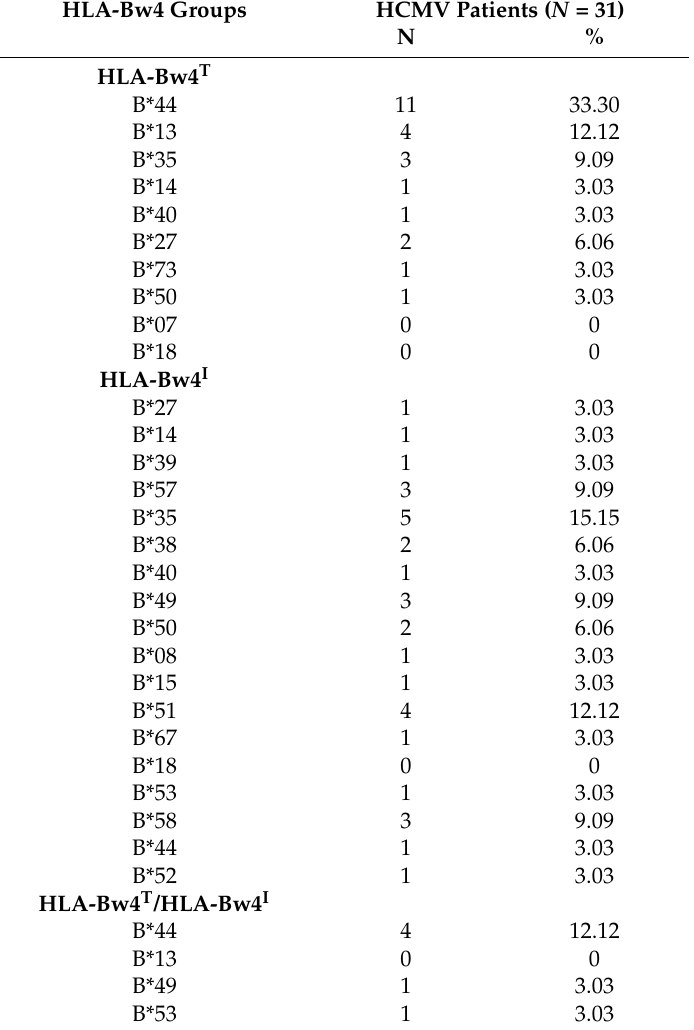
Table 1. Distribution of HLA-B alleles in Human cytomegalovirus (HCMV) symptomatic patients positive for the different HLA-Bw4 groups. (The number of alleles is twice the number of subjects, as each person has two alleles—one maternal and one